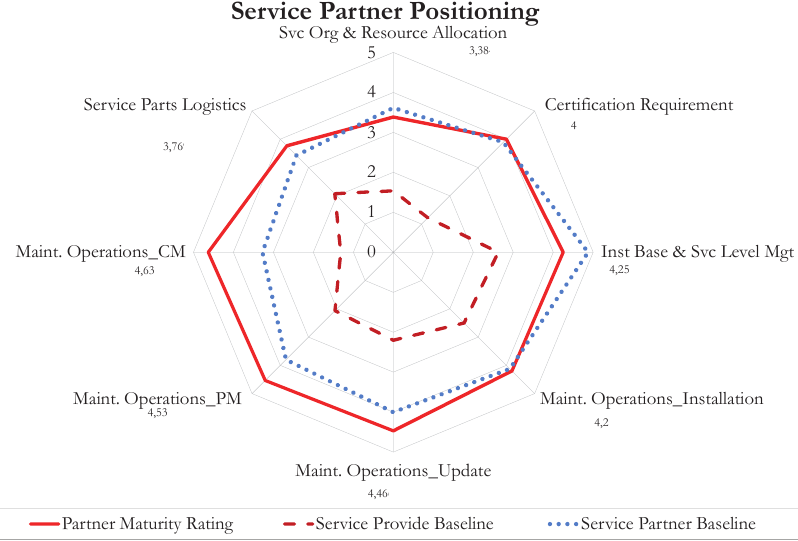
Fig. 6 – Spider graph of final achievements. Source: own.